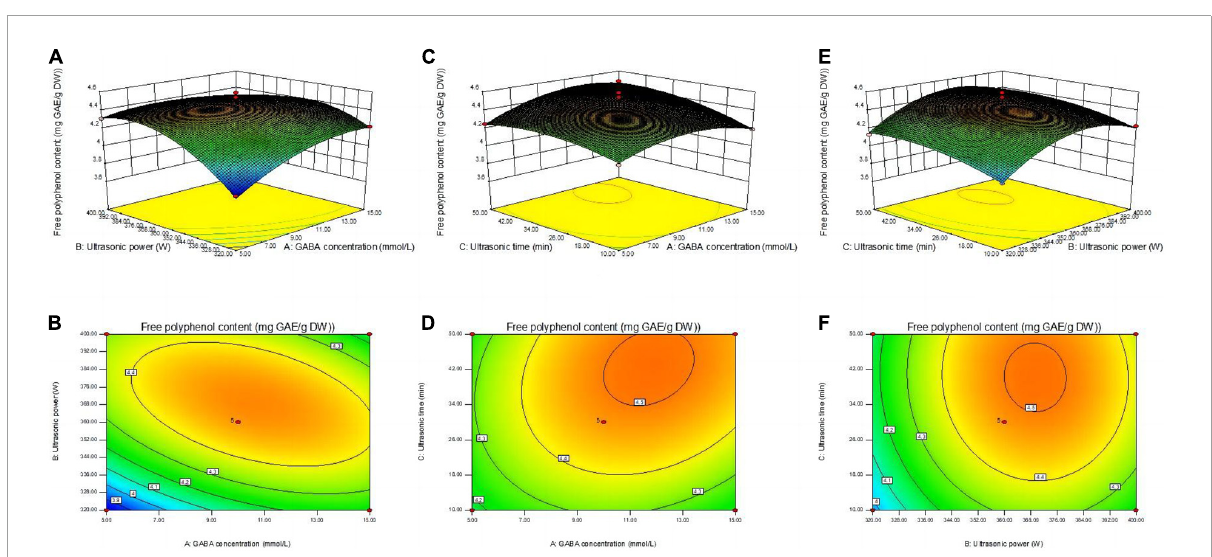
FIGURE2 Contour lines and response surface diagrams of the interaction between X 1 X 2 (A,B) , X 1 X 3 (C,D) , and X 2 X 3 (E,F) . (X 1 ) GABA concentration, (X 2 ) ultrasonic power, and (X 3 ) ultrasonic